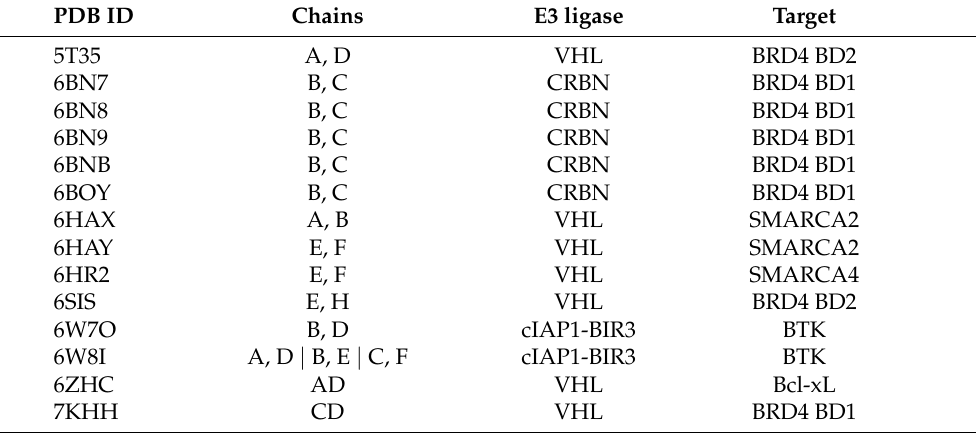
Table 3. Ternary complex dataset. In addition to the unique PDB identifiers and two chains we select for prediction, we also quote the name of E3 ligases and targets/POI (and domain of binding if applicable) [55,56]. Note that for the PDB identifier 6W8I, three distinct pairs of chains are considered, which define BTK bound to the BIR3 domain of